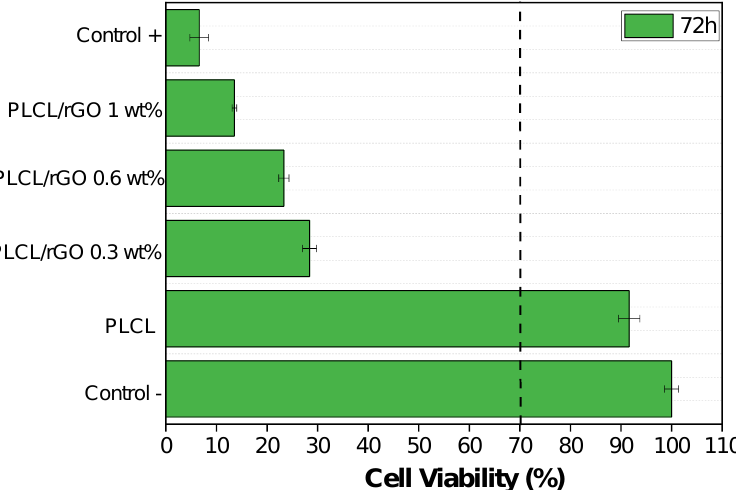
Figure 11. Cell viability of C2C12 cells in contact with the conditioned media exposed with PLCL with different % of rGO up to 72 h.